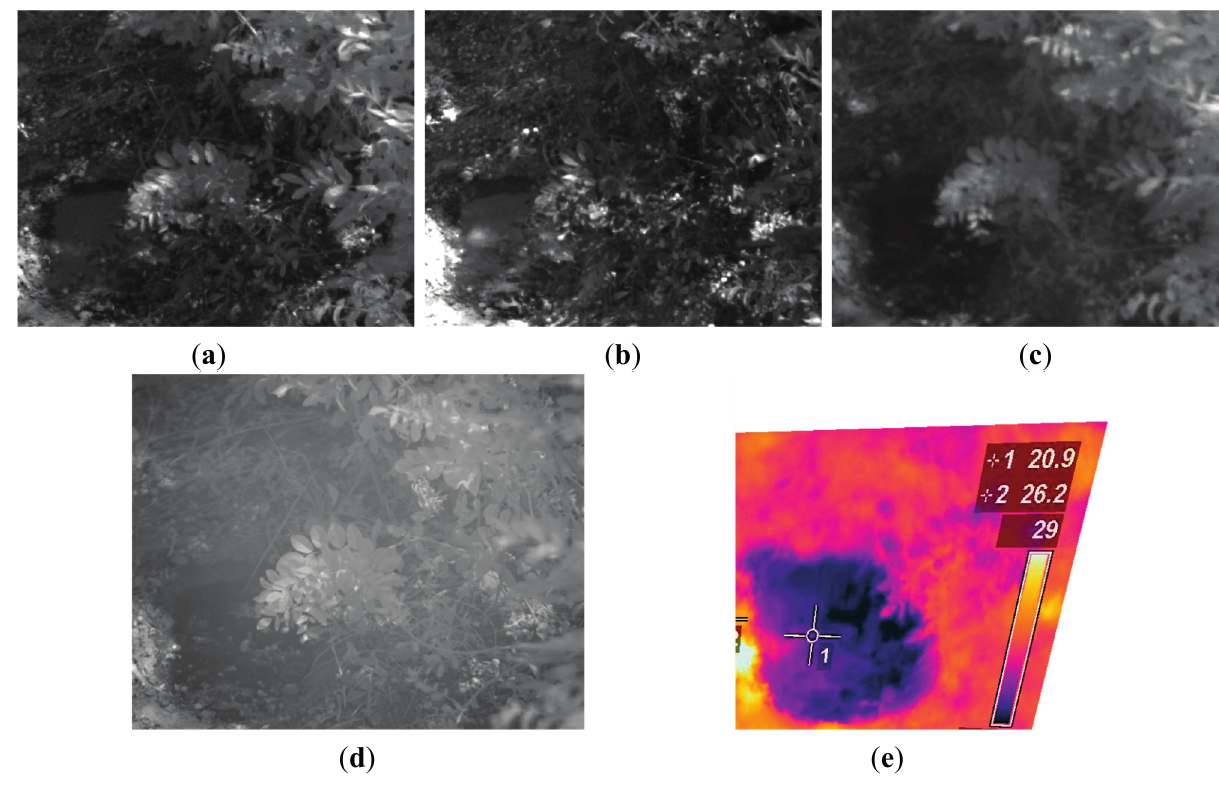
Figure 12. Registered images. ( a ) Registered monochrome image; ( b ) Registered 624 nm image; ( c ) Registered 950 nm image; ( d ) Registered SWIR image; ( e ) Registered LWIR